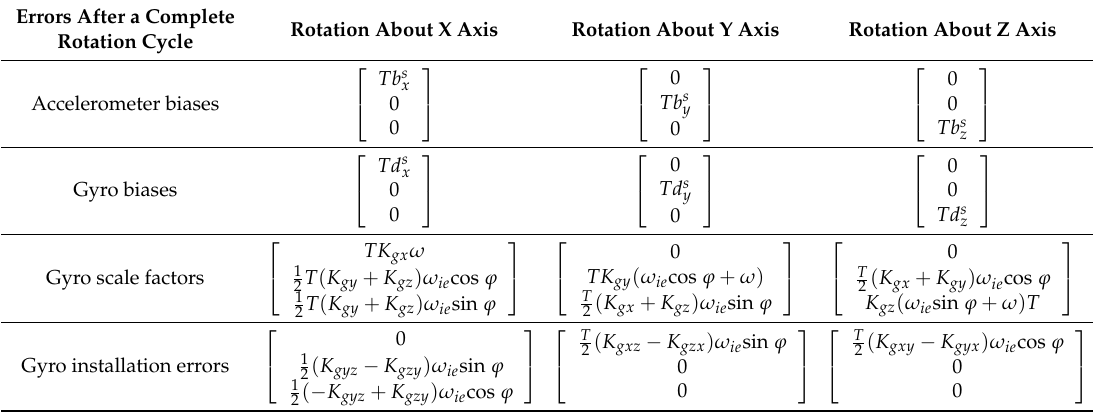
Table 1. Errors after a complete rotation cycle for IMU rotation about X-, Y- and Z-axes. Errors After a Complete Rotation About X Axis Rotation About Y Axis Rotation About Z Axis Rotation Cycle Accelerometer